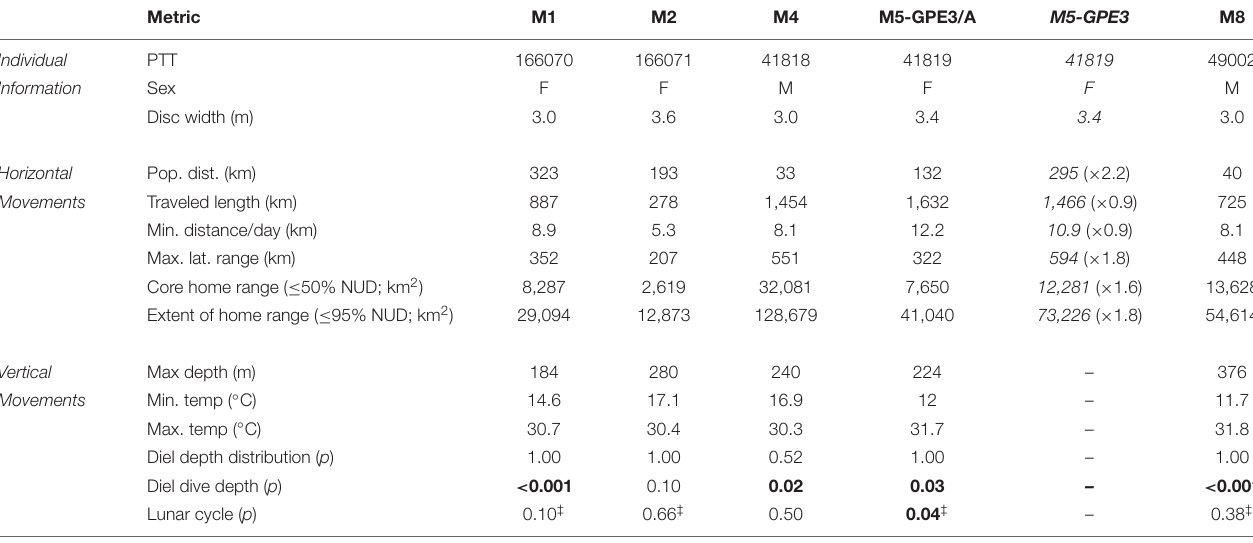
TABLE 3 | Horizontal and vertical movement metrics for reef manta rays ( Mobula alfredi ) tracked using archival pop-up satellite tags (miniPATs) in Seychelles. Metric